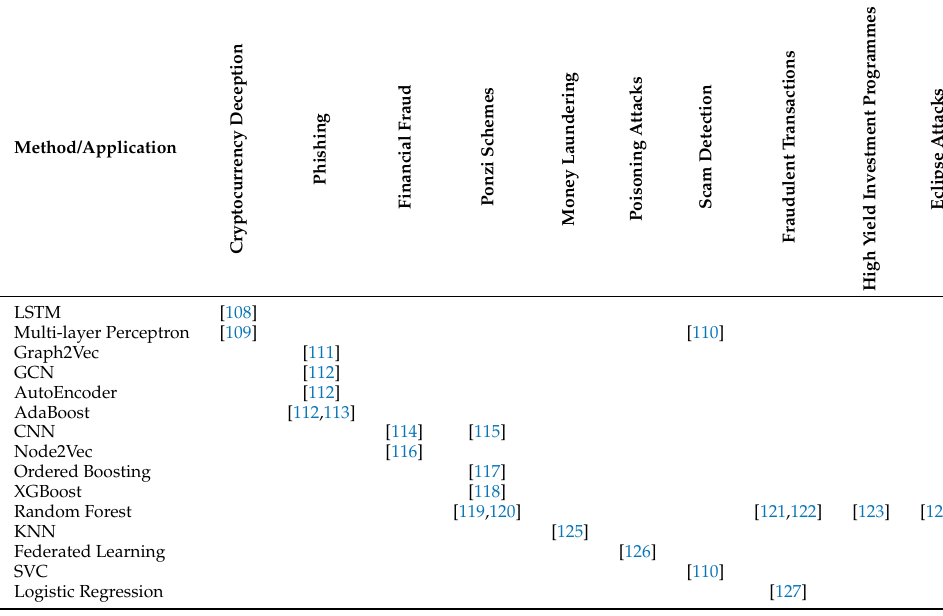
Table 7. Financial fraud